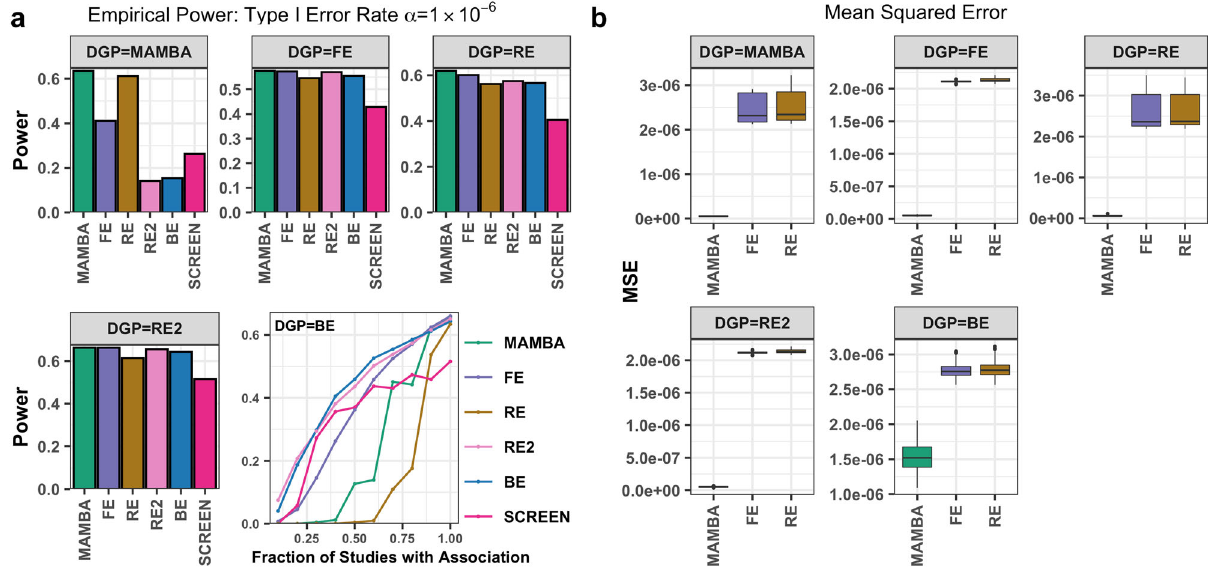
Fig. 2 Comparison of power and the mean square error for different methods in simulation studies. a The power was evaluated using 1 million replications at the signi fi cance threshold of α = 1 × 10 − 6 . b The mean-squared error for the genetic effect estimates were evaluated for MAMBA, fi xed effect (FE) and random effect meta-analysis (RE). The RE2, BE, and SCREEN methods do not produce genetic effect estimates and thus were not considered. Scenarios under different data generation process (DGP) were considered. Source data are provided as a Source Data fi